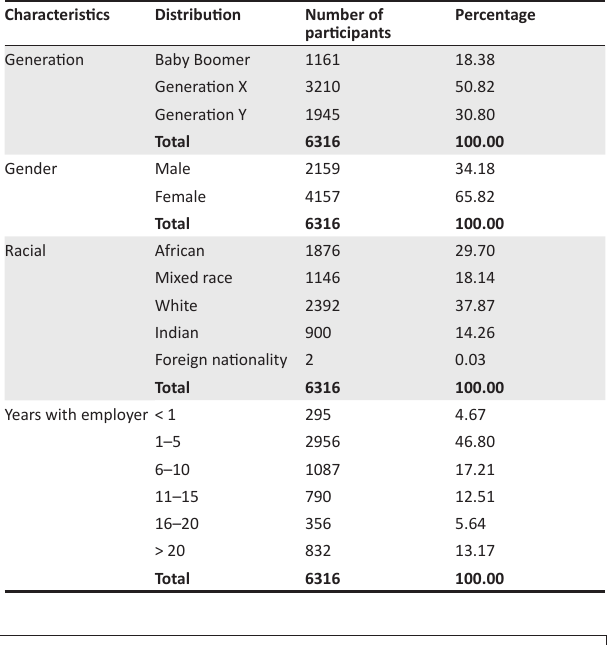
TABLE 3: Demographic characteristics of the respondents.